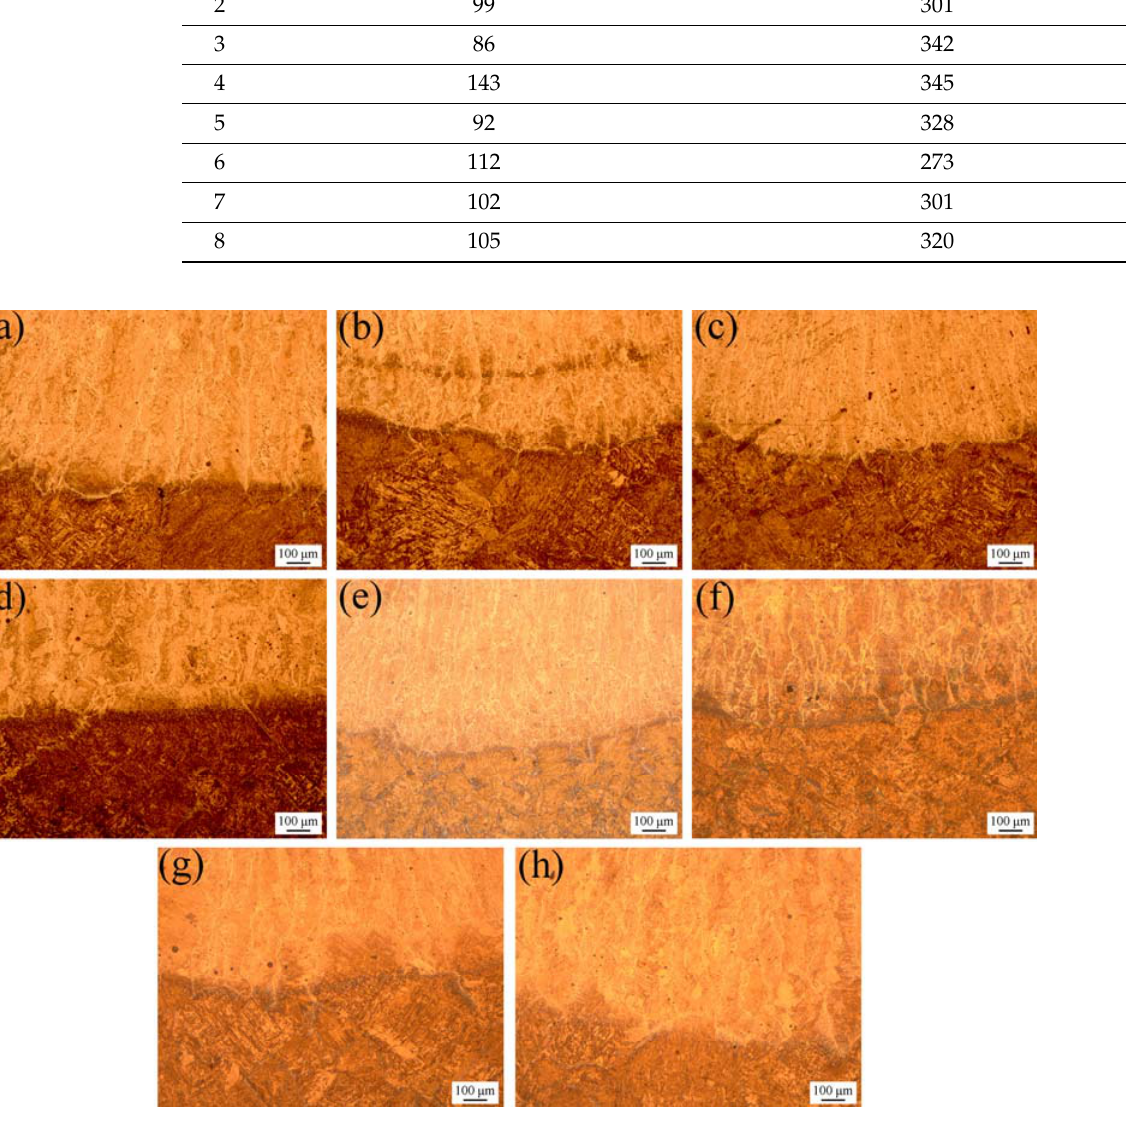
Figure 12. Microstructure of fusion line under different ultrasonic excitation parameters: ( a ) con